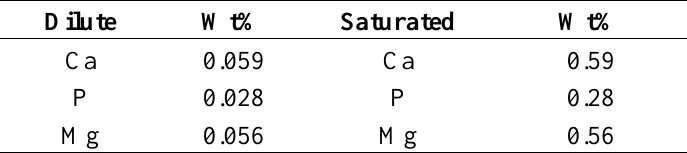
Table 1. The weight % of salt in the solution for dilute (10% concentration) and saturated (100% concentration).